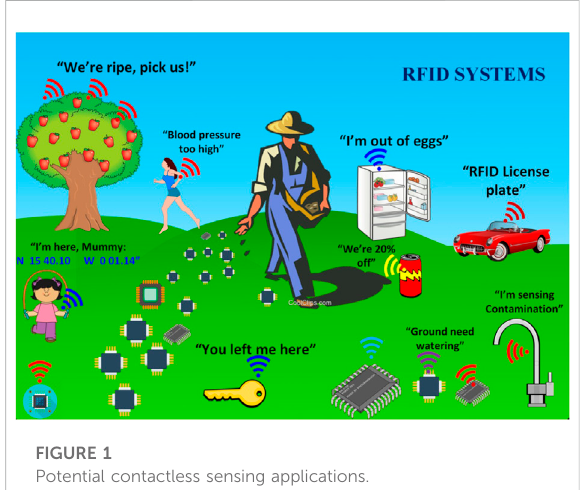
FIGURE 1 Potential contactless sensing